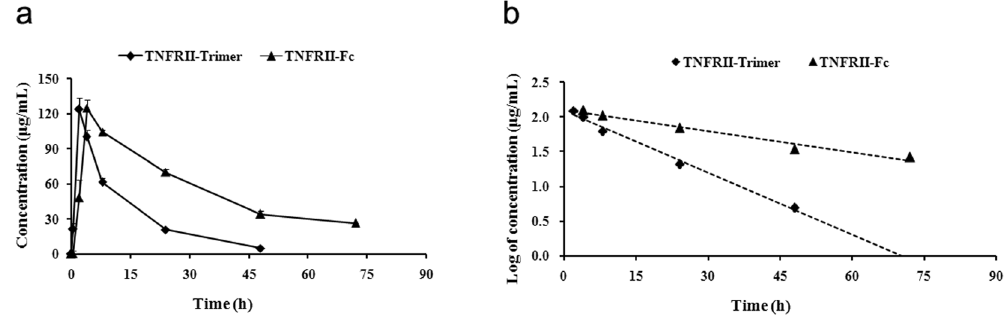
Figure 5. Pharmacokinetics analysis of TNFRII-Trimer and TNFRII-Fc in DBA/1 mice. ( a ) Plasma concentrations versus time profile of TNFRII-Trimer after i.p. administration of TNFRII-Trimer and TNFRII-Fc in DBA/1 mouse. ( b ) Plasma concentration (log-scale) versus time profile of TNFRII-Trimer and TNFRII-Fc after i.p. administration in DBA/1mouse. Data represented mean ± SD (n =